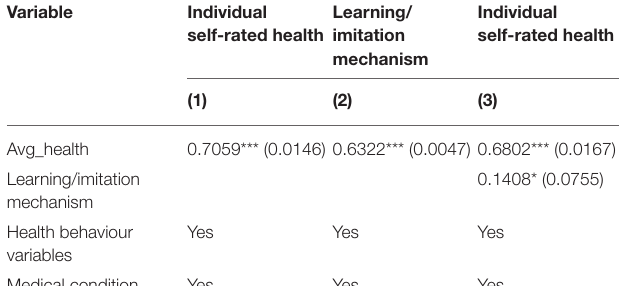
TABLE 8 | Regression results for different age groups of healthy infectiousness. Variable